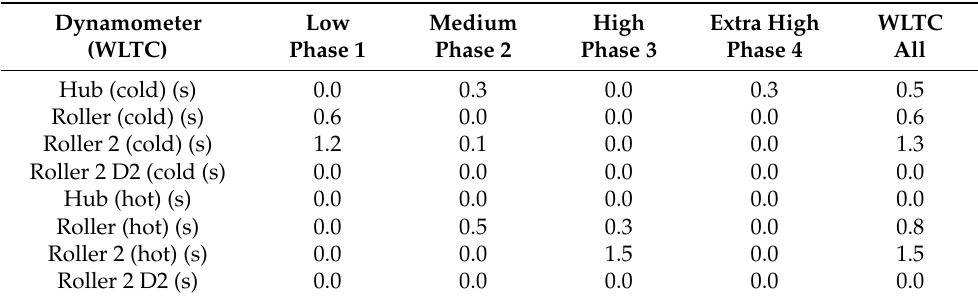
Table 3. Total time violations with the roller- and hub-type dynamometers for the cold- and hot-start WLTCs. D2 = second driver.